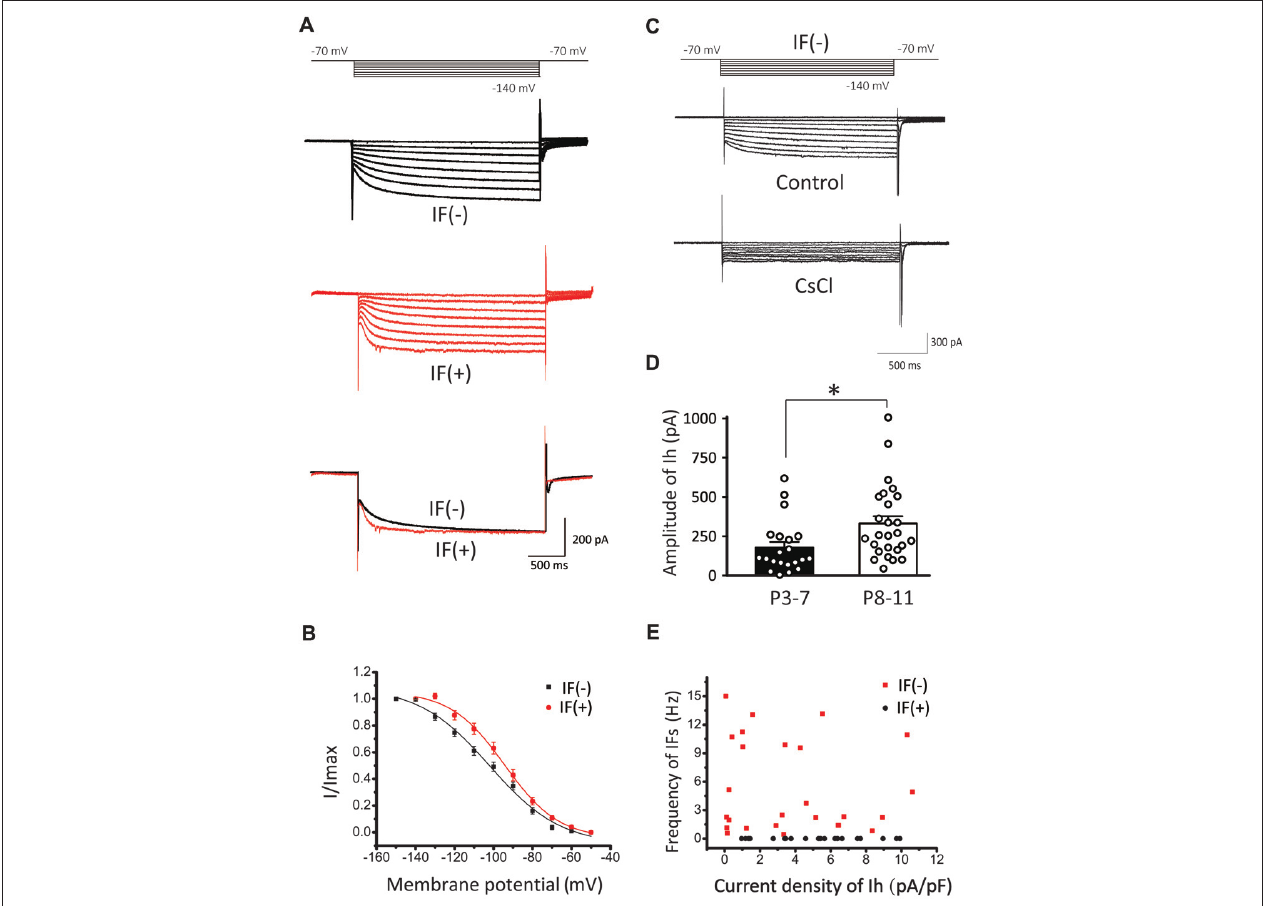
FIGURE 4 | Comparison of I h in IF(+) and IF( − ) neurons. (A) Upper and middle panel: representative I h recorded from IF(+) and IF( − ) neurons. The membrane potential was held at − 60 mV before different voltage steps ranging from − 70 to − 140 mV (in − 10 mV increment) for 2 s as shown by the protocols above current traces. Lower panel: comparison of activation kinetics of HCN currents evoked at − 140 mV from IF(+) and IF( − ) neurons. (B) Activation curve of I h in CN neurons from IF(+) and IF( − ) neurons, fit with the Boltzmann function. (C) Representative I h in IF( − ) neuron, which can be blocked by CsCl. (D) The plot of I h amplitude and age groups (P3–7 and P8–11). (E) Scattered plot of IFs frequency against I h current density for both IF(+) and IF( − )